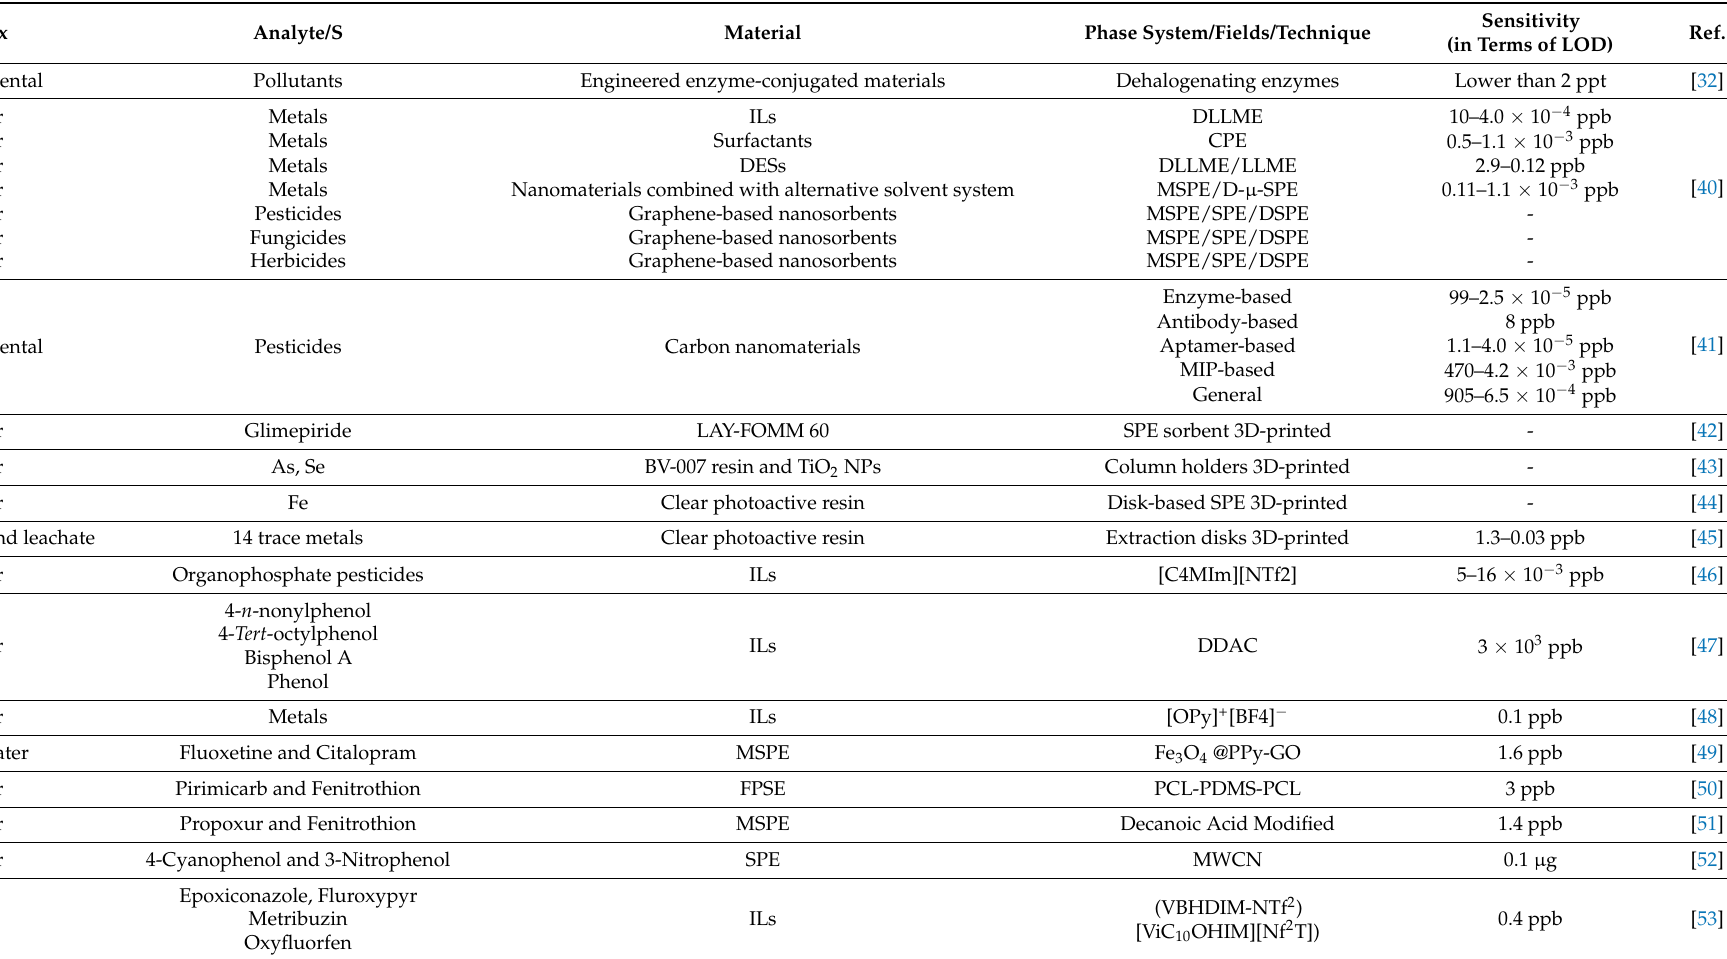
Table 1. Most key developments in extraction